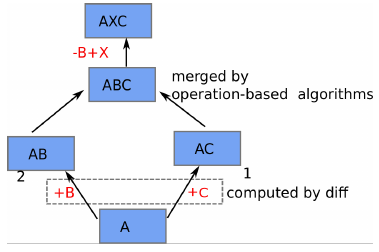
Figure 5. Imitate human merge